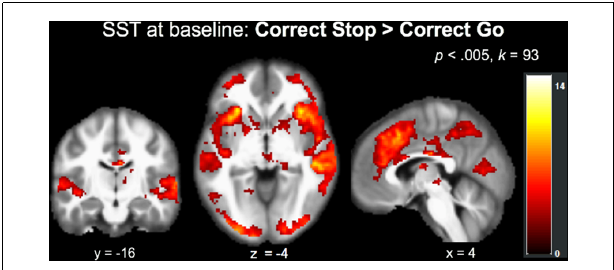
FIGURE 2 | Recruitment of regions implicated in inhibitory control during the SST (Correct Stop > Correct Go) at baseline across the entire sample ( N = 37).